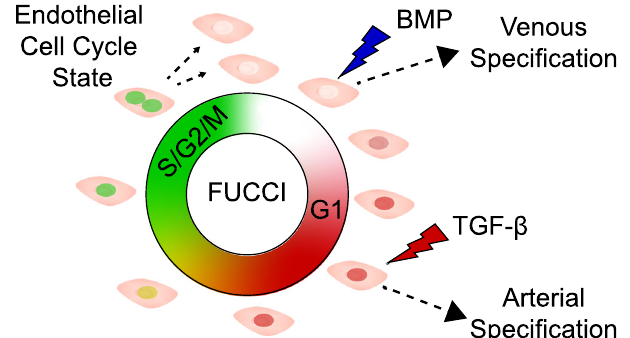
Fig.8 |Cellcyclestatedeterminespropensityforarterial – venousspeci fi cation hypothesis. Early G1 state allows for greater induction of venous speci fi cation by BMP signaling, while late G1 state allows for greater induction of arterial speci fi - cation by TGF- β